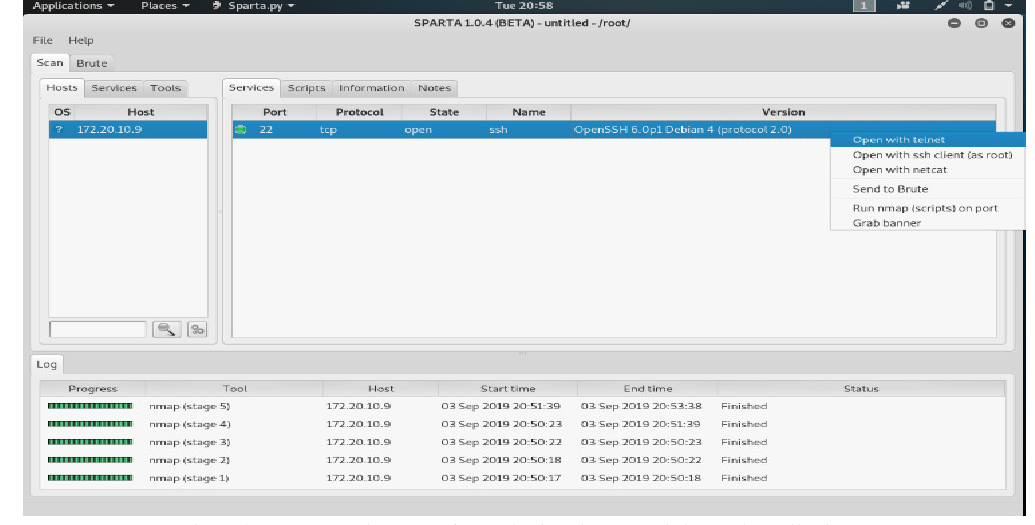
Fig. 14: Stages and types of attacks implemented through Kali